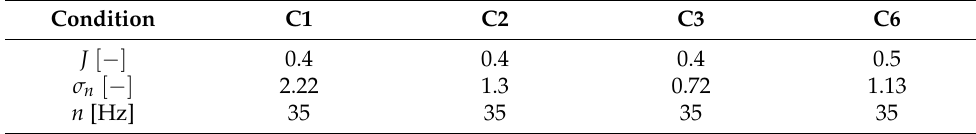
Table 2. Newcastle test case. Considered test conditions from round-robin test.